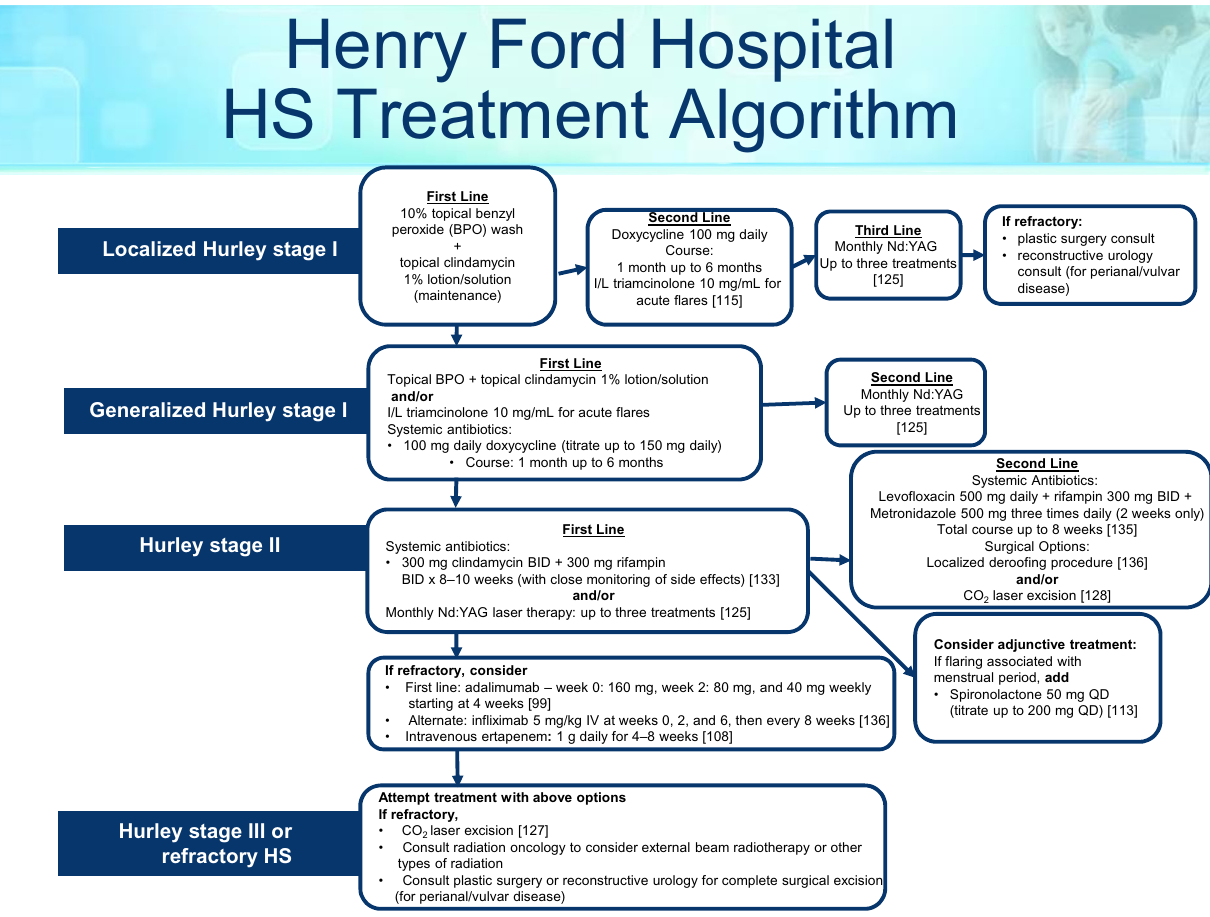
Figure 1. Henry Ford Hospital hidradenitis suppurativa (HS) treatment algorithm. This treatment algorithm is used in the Henry Ford Dermatology Clinic, which provides care to more than 1,000 patients with HS. The algorithm is based on a combination of evidence-based research and provider experience. BID, bis in die ; I/L, intralesional; IV, intravenously; Nd:YAG, neodymium-doped yttrium aluminum garnet; QD, quaque